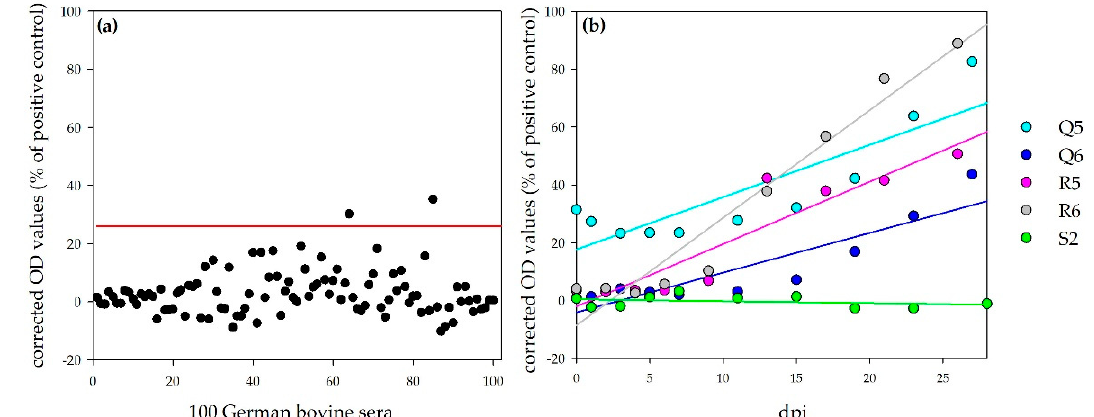
Figure 7. NSDV ELISA results for bovines: Panel ( a ) shows the results for 100 German bovine reference sera for the determination of the negative cut-off (illustrated by the red line; specificity, 98%). Panel ( b ) shows the results for the challenged calves. Whereas the OD values for the control calf (S2) stayed on the same level, linear regressions (calculation performed by Sigmaplot) show a steady increase in OD values for the infected calves.